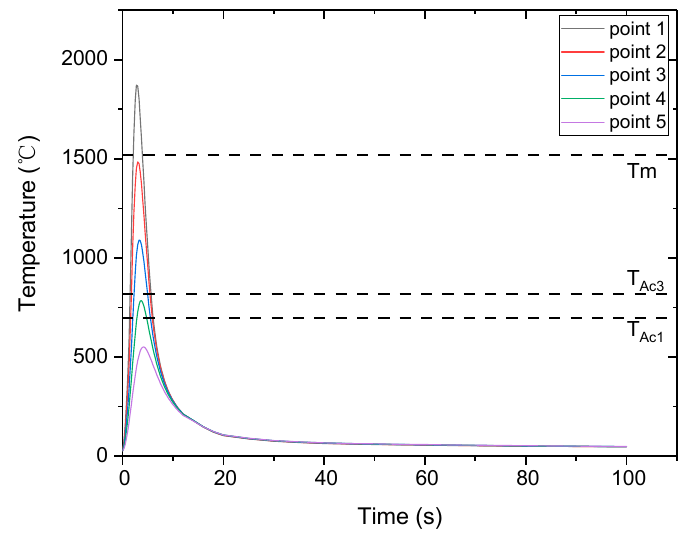
Figure 8. Thermal cycles at di ff erent locations.